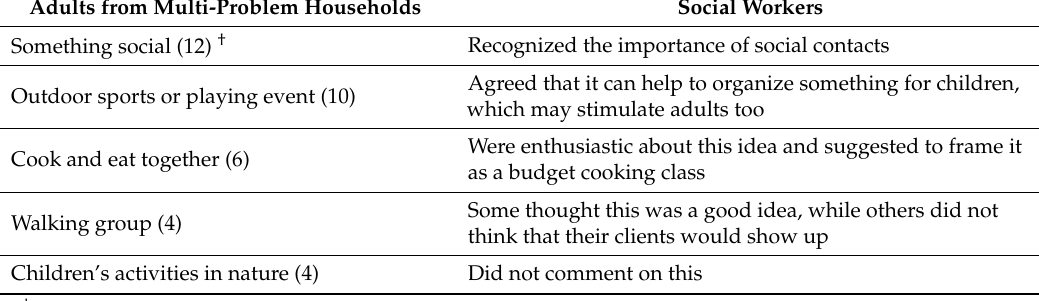
Table 4. Most often mentioned ideas for a health promotion intervention by participants and responses of social